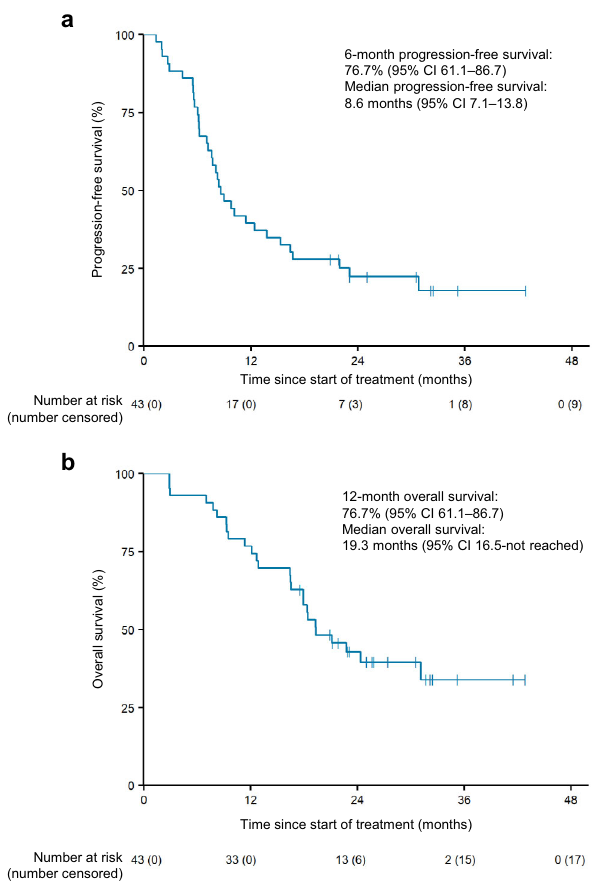
Fig. 3 | Progression-free survival and overall survival. a Kaplan – Meier curves of progression-free survival for all patients. b Kaplan – Meier curves of overall survival for all patients. Crosses denote censored observation, and number at risk is indi- cated below the